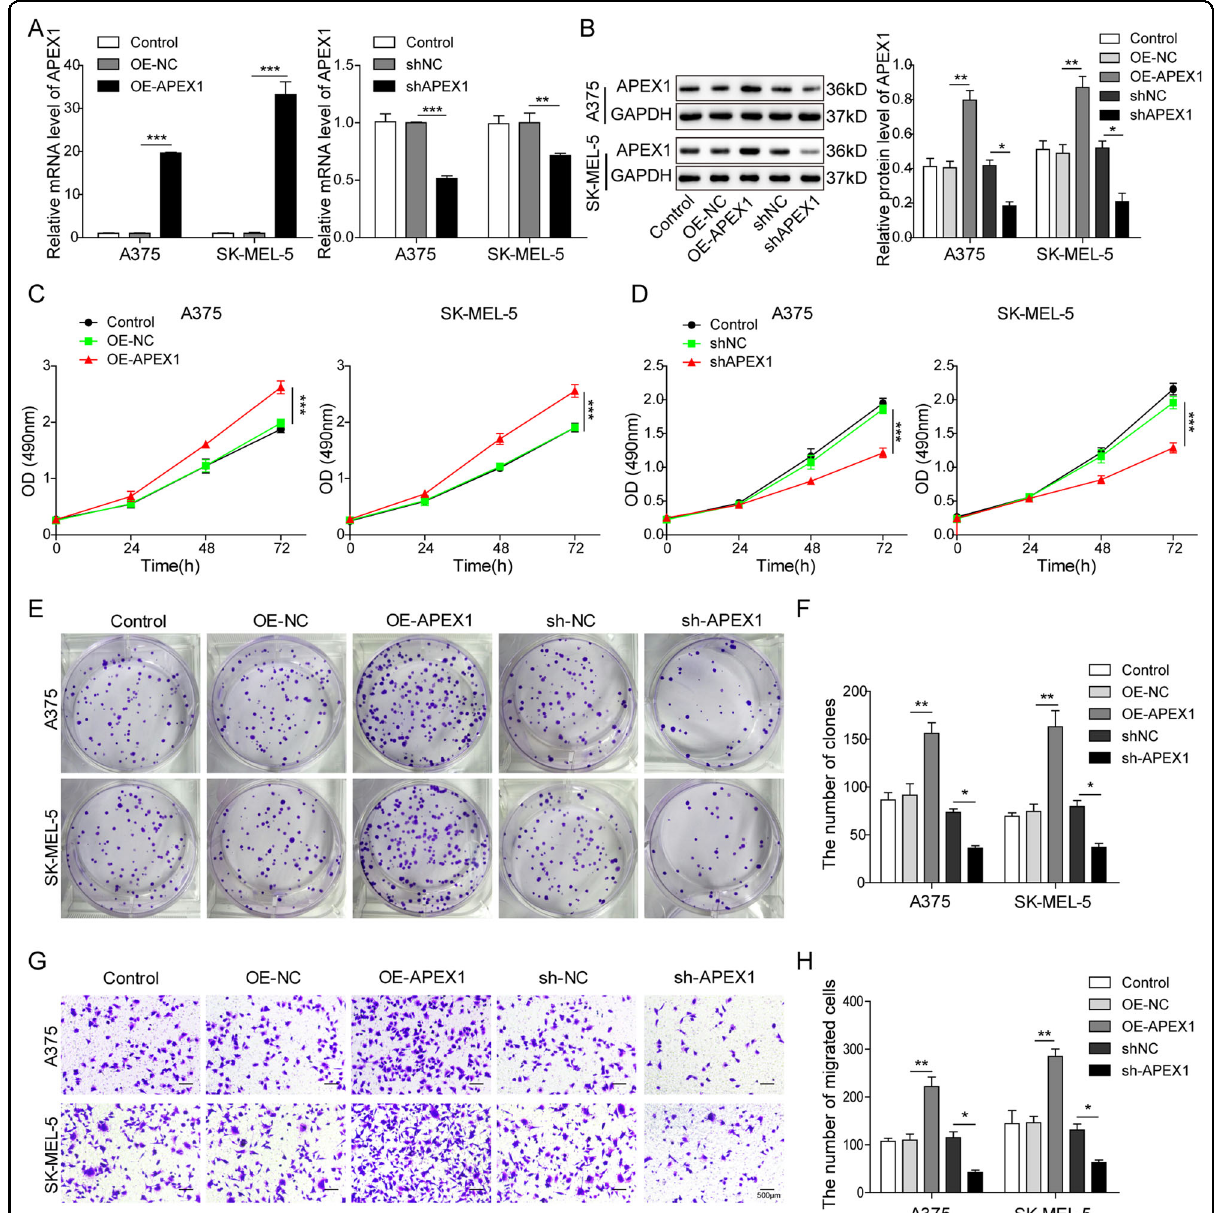
Fig. 1 APEX1 facilitated the proliferation and migration of melanoma cells. A , B qRT-PCR and WB analysis of APEX1 of A375 and SK-MEL-5 cells after transfection with OE-NC, OE-APEX1, shNC, and sh-APEX1, respectively. C MTT assay of the cells transfected with control, OE-NC, and OE-APEX1. D MTT assay of the cells transfected with control, sh-NC, and sh-APEX1. E , F The colony formation assay of A375 and SK-MEL-5 cells after transfected with control, OE-NC, OE-APEX1, sh-NC, and sh-APEX1. G , H The transwell assay was used to evaluate the migration ability of the cells after transfected with control, OE-NC, OE-APEX1, sh-NC, and sh-APEX1. The mean ± SD in the graph shows the relative levels from three replicates. *p < 0.05, **p <